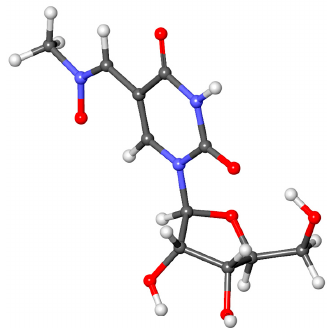
Figure 4. Optimized geometry of ( Z ) aldonitrone 1 showing a planar arrangement for optimal electron delocalization between aldonitrone moiety and nucleobase.